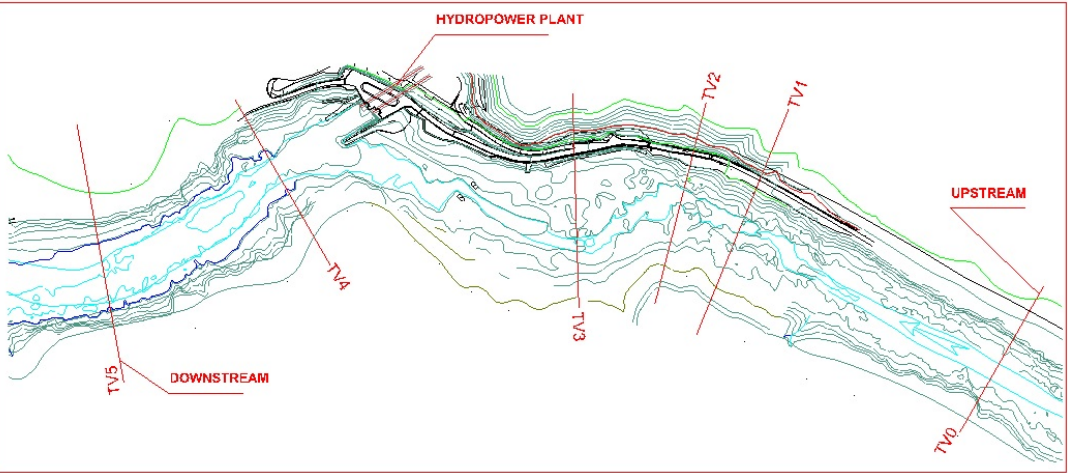
Figure 6. Plain view of river segment flow throught Ialy hydropower plant.